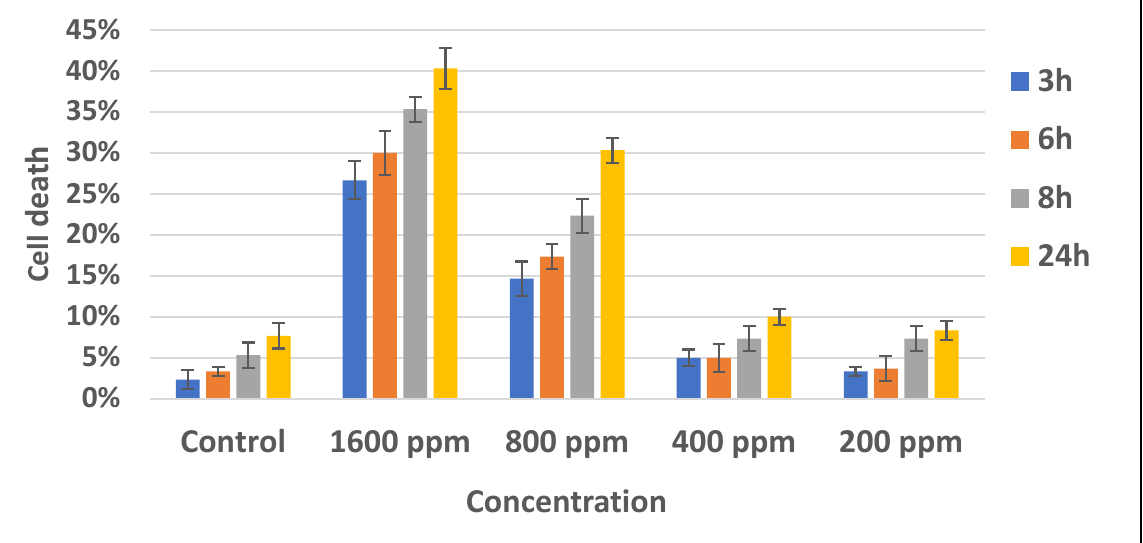
Figure 4. Brenia cernua induced the death of MCF ‐ 7 cancer cells (dose and time dependency). The cell viability was estimated by measuring the absorbance at λ 570 nm using a Quant ELISA plate reader (Agilent BioTek Instruments). Control: cancer cells treated with solvent (DMSO 0.5% v / v ).